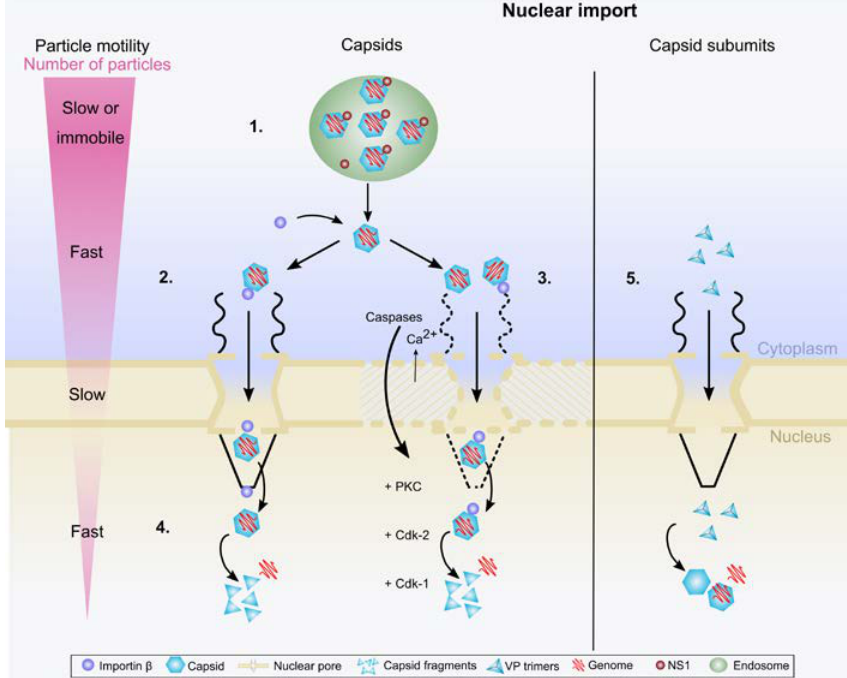
Figure 1. Overview on the parvoviral nuclear import. ( 1 ) Viruses enter the cell by endocytosis. Inside the endosome viral NLS is exposed and the NS1 protein is detached from the capsid. Endosomal escape is followed by cytoplasmic interaction of capsid with importin β. In the cytoplasm viruses exploit dynein- and microtubule-mediated transport towards the nucleus; ( 2 ) after reaching the nuclear envelope, viruses are transported through the nuclear pore complex; ( 3 ) the direct or importin-mediated indirect interaction with the nuclear pores may also induce nuclear envelope breakdown allowing virus entry into the nucleoplasm. Host cell caspases, nuclear inflow of Ca 2+ , and activation of mitotic enzymes including Cdk-1/2 and PKC are involved in this process; ( 4 ) nuclear import is followed by viral capsid disassembly and release of their genome in the nucleoplasm; ( 5 ) in the late stage of infection, the newly synthesized viral capsid proteins are imported into the nucleus as phosphorylated trimeric assembly intermediates.